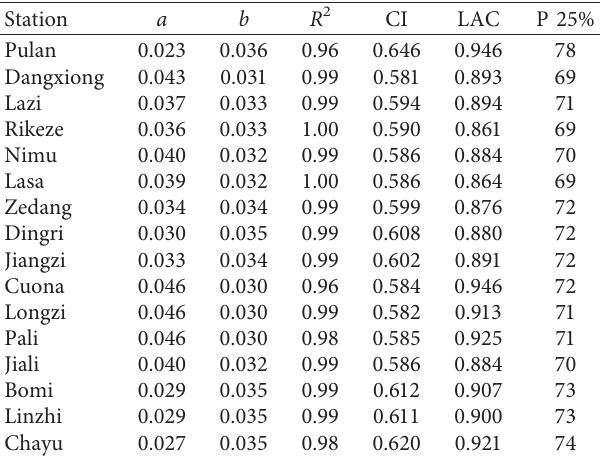
Table 2: Values for the constants, a and b, of the exponential curves, coefficients of determination ( R 2 ), CI, LAC, and percentage of precipitation contributed by 25% of the rainiest days (P